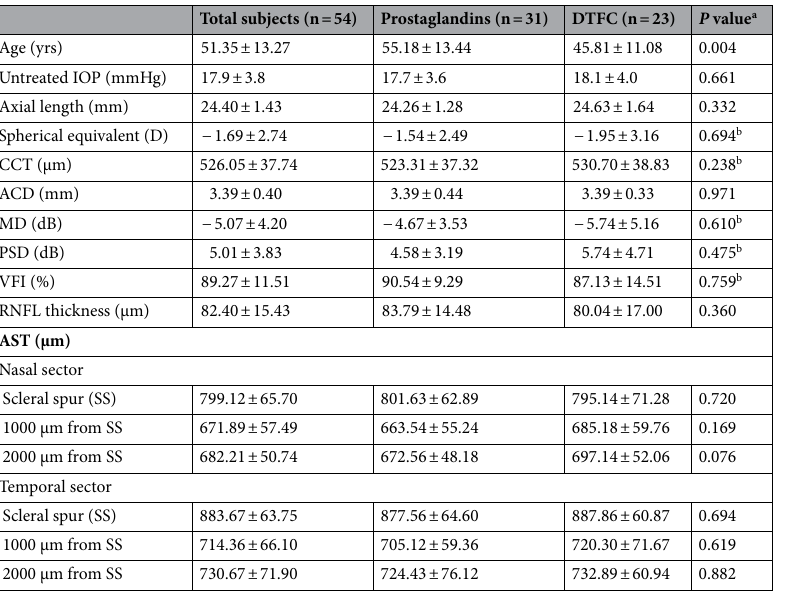
Table 1. Baseline characteristics of the subjects. DTFC dorzolamide/timolol fixed combination, IOP intraocular pressure, CCT central corneal thickness, ACD anterior chamber depth, MD mean deviation, PSD pattern standard deviation, VFI visual field index, RNFL retinal nerve fiber layer, AST anterior scleral thickness. a Independent t-test, b Mann-Whitney U